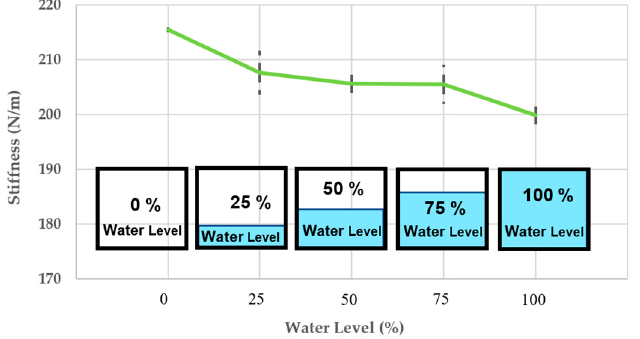
Figure 15. The change of sti ff ness.